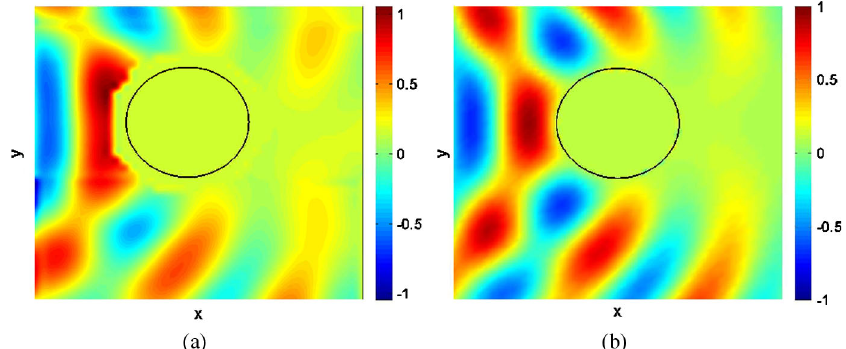
FIG. 4. (a) The real part of the total measured electric field for a point source scattering off of an aluminum cylinder. The inner circle shows the boundary of the aluminum cylinder. (b) The real part of the total electric field for a point source scattering off of a PEC cylinder, as found using COMSOL multiphysics.